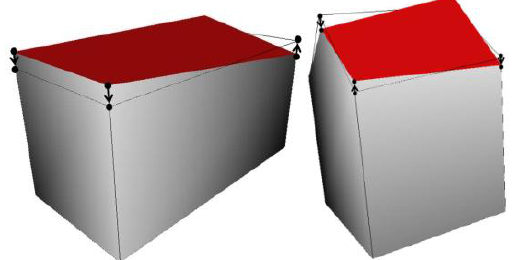
Figure 8. Healing of the LOD1 and LOD2 RoofSurface